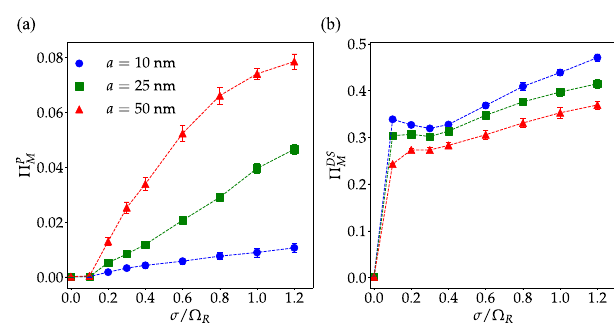
Fig. 5 Polariton and dark-state delocalization dependence on the energetic disorder and density for fi xed Ω R . a Total contribution of polariton states (with photonic content >15% but <85%) to the molecular excited-state survival probability vs. energetic disorder (with zero detuning and Ω R = 0.3 eV). b Total contribution of dark states (with molecular content >85%) to the molecular survival probability. Excited-state localization leads to an increase in the survival probability and therefore, we can infer both polaritons and reservoir modes become more localized with increasing σ , although the effect is much stronger on the latter, especially at small values of σ / Ω R . Each point corresponds to the average over 20 disorder realizations (error bars indicate standard deviation).